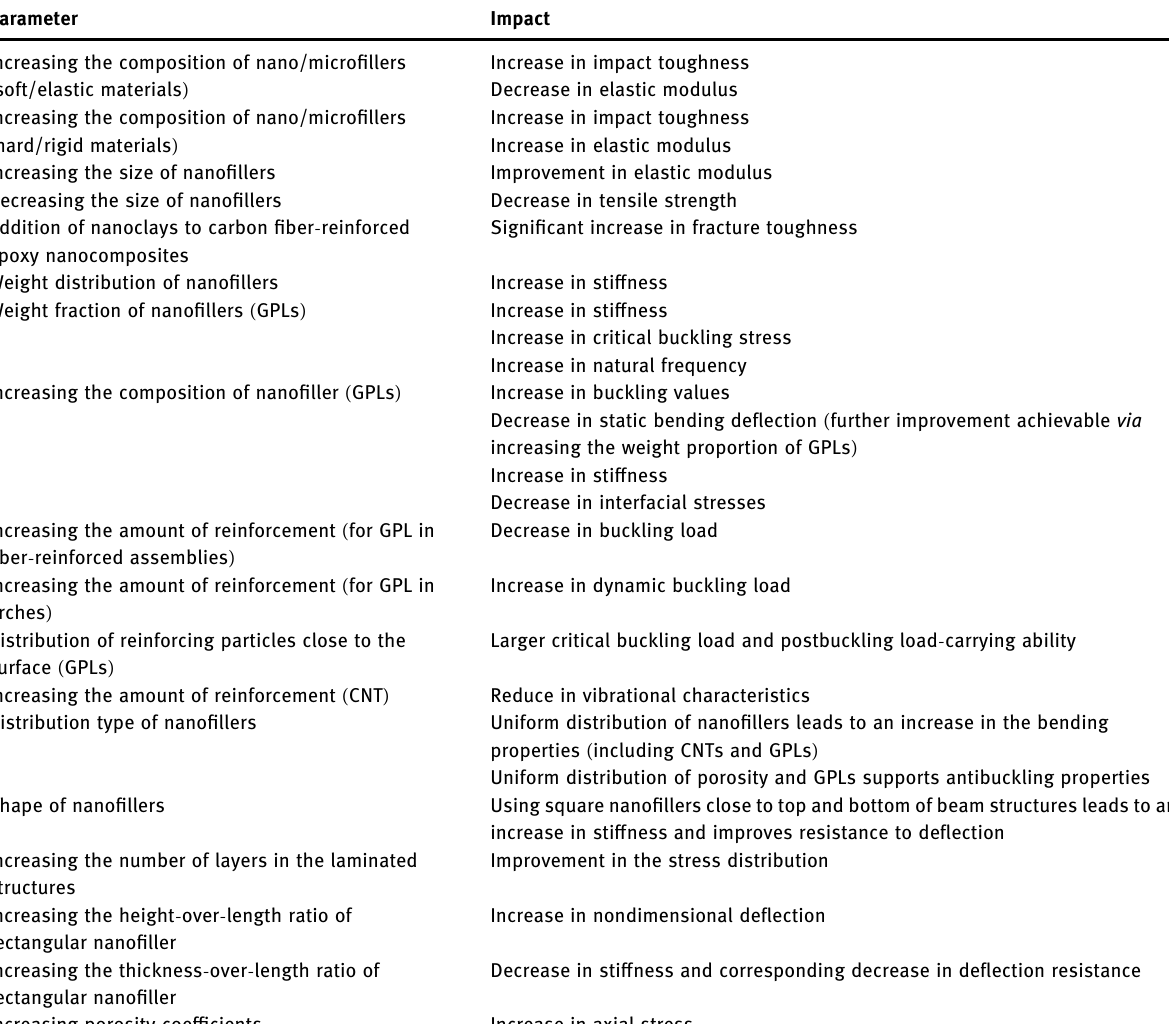
Table 2: Classi fi cation of di ff erent parameter impacts on the operation performance Parameter